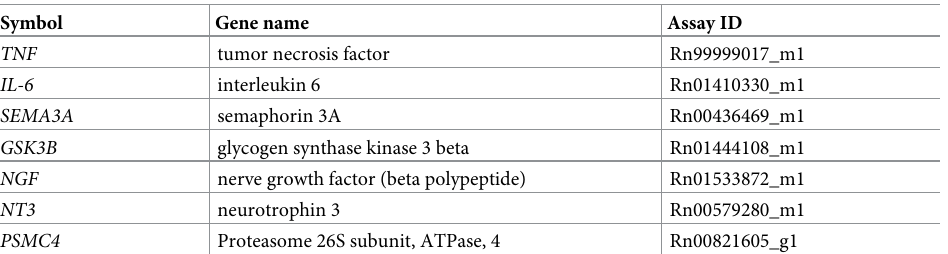
Table 1. TaqMan gene expression assays for real-time